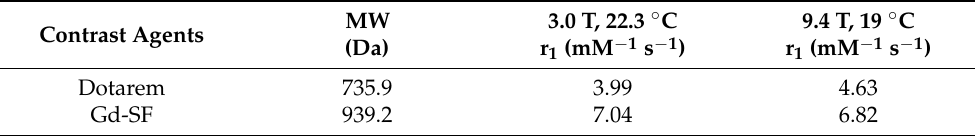
Table 1. In vitro relaxivity values at 3.0 T, 22.3 ◦ C and 9.4 T, 19 ◦ C for Dotarem and Gd-DOTA-click-SF